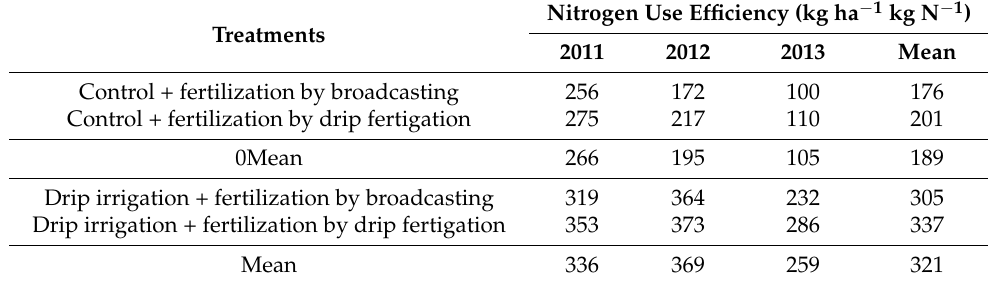
Table 10. Nitrogen use efficiency in the years